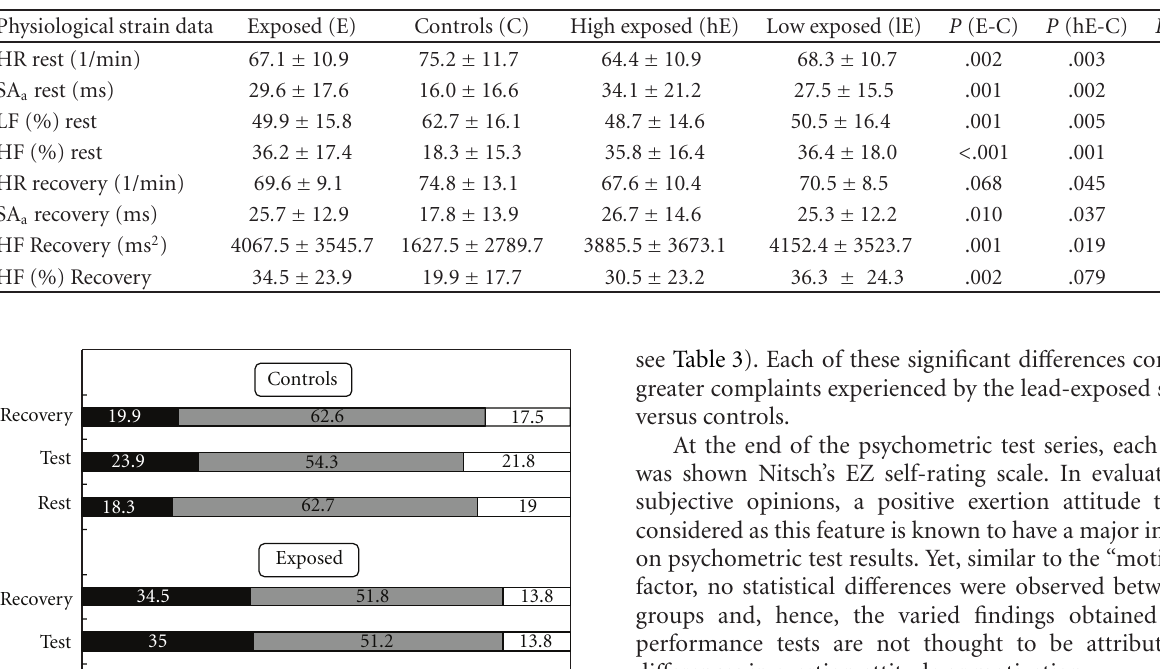
Table 2: Comparison of a number of cardiovascular parameters of lead-exposed subjects (E) involving the subgroups of high-exposed (hE) and low-exposed (lE), and controls (C) at rest and during recovery.